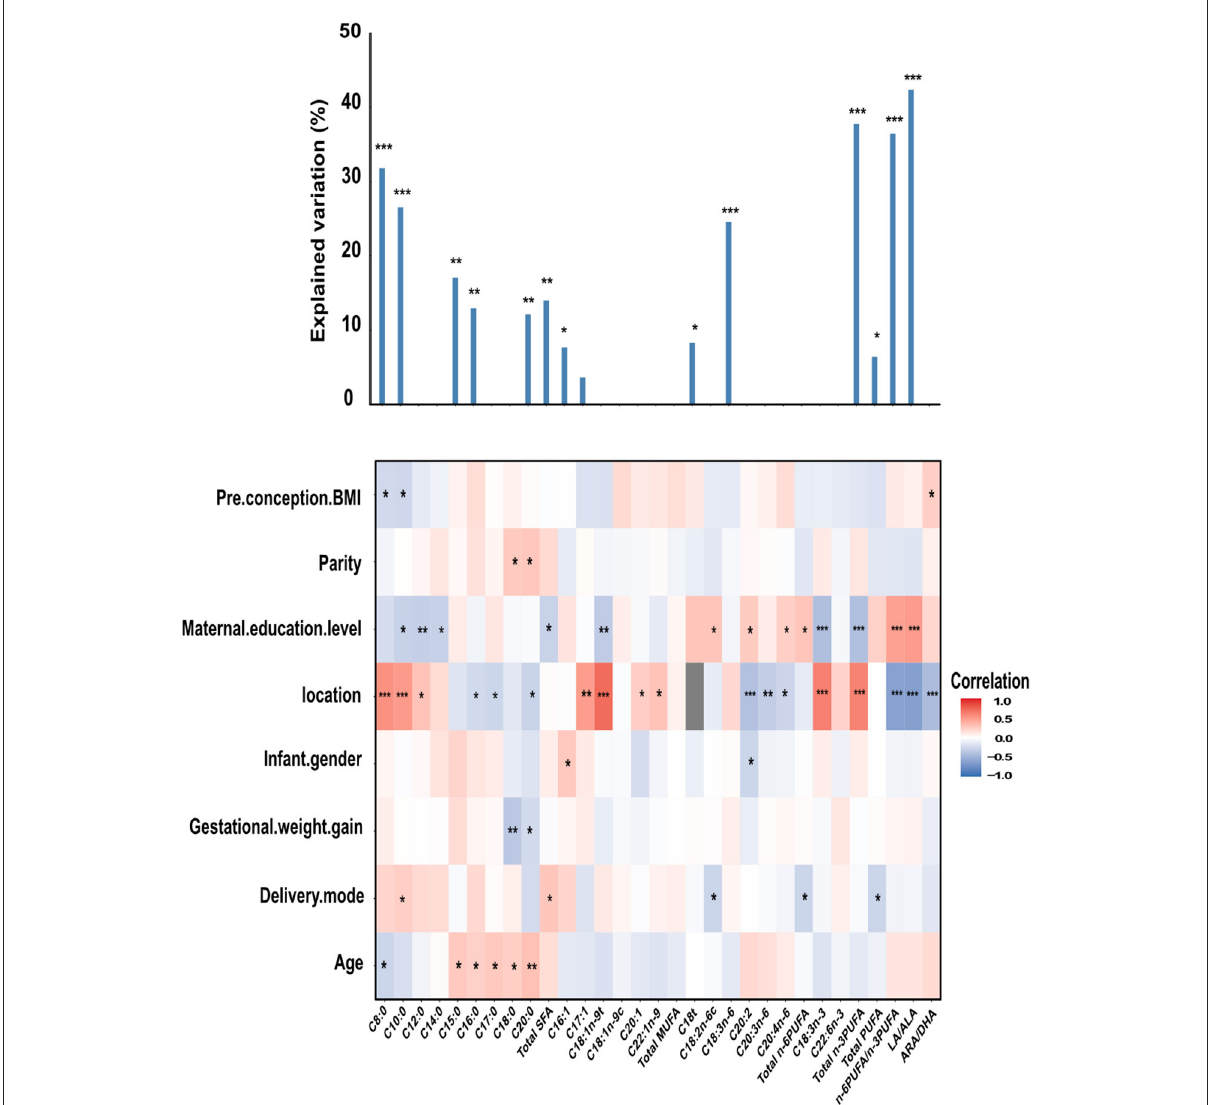
FIGURE1 The column chart shows the total contribution of indicators to the interpretation of FAs variation (obtained by multiple linear regressions). The heat map shows the Spearman correlations between total FAs and correlated factors. Coloring reflects the direction and magnitude of the correlation coefficients. For pre-conception BMI, parity, maternal education level, gestational weight gain, and age, the higher the value/level of the correlated factors, the higher the fatty acid content. For the location, red indicates FAs in Danyang are higher than that in Beijing. For infant gender, red indicates FAs in mothers with baby girls are higher than that with baby boys. For delivery mode, red indicates FAs of mothers with natural childbirth are lower than with other modes of delivery. The major predictors were identified based on the correlation and best multiple regression model. C18t is the sum of C18:1t, C18:2t, and C18:3t, representing the level of trans FAs. LA, linoleic acid (C18:2n-6c); ARA, arachidonic acid (C20:4n-6); ALA, α -linolenic acid (C18:3n-3); DHA, Docosahexaenoic acid (C22:6n-3). * P < 0.05; ** P < 0.01; *** P <